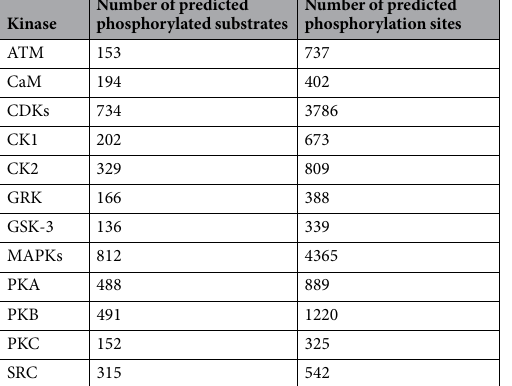
enrichment for the corresponding GO term. Only the top five most enriched GO terms for the four kinases CDKs, MAPKs, PKC and CK2 are displayed in Fig. 5. Phosphorylated substrates of different kinases are commonly located in the membrane regions (e.g. integral to membrane, intrinsic to membrane, plasma membrane and mitochondrial outer membrane). We also show that phosphorylated substrates are present in diverse cellular processes and pathways, including intracellular signaling cascades, cell surface receptor-linked processes, ion transport, cell adhesion, and sensory perception (Fig. 5).